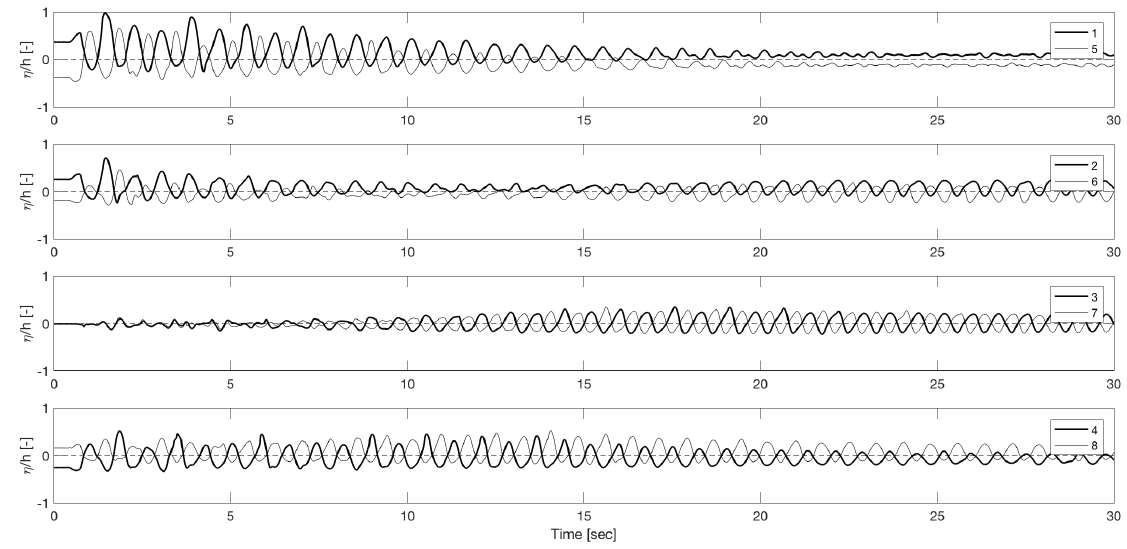
Figure 7. Results of the transient experiment—wave gauges (WG) in pairs as defined in Figure 2—normalised surface elevation η / h .